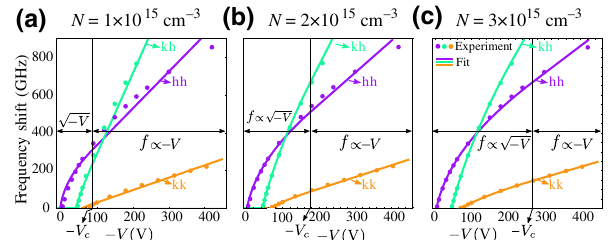
FIG. 9. Fit for the frequency shift versus voltage V for the (cid:22) (cid:22) (cid:23) (cid:23) (cid:22) (cid:22) (cid:2) and (cid:2) (hh) and (kk) transitions and → | T → | T E 1,2 E y ± (cid:22) (cid:22) (cid:24) (cid:24) 0 (cid:22) (cid:22) → (cid:22) ˜ A (cid:22) A (cid:5) (kh) transition for densities (a) N = 1 × for the 0 0 10 15 cm − 3 , (b) N = 2 × 10 15 cm − 3 , and (c) N = 3 × 10 15 cm − 3 .